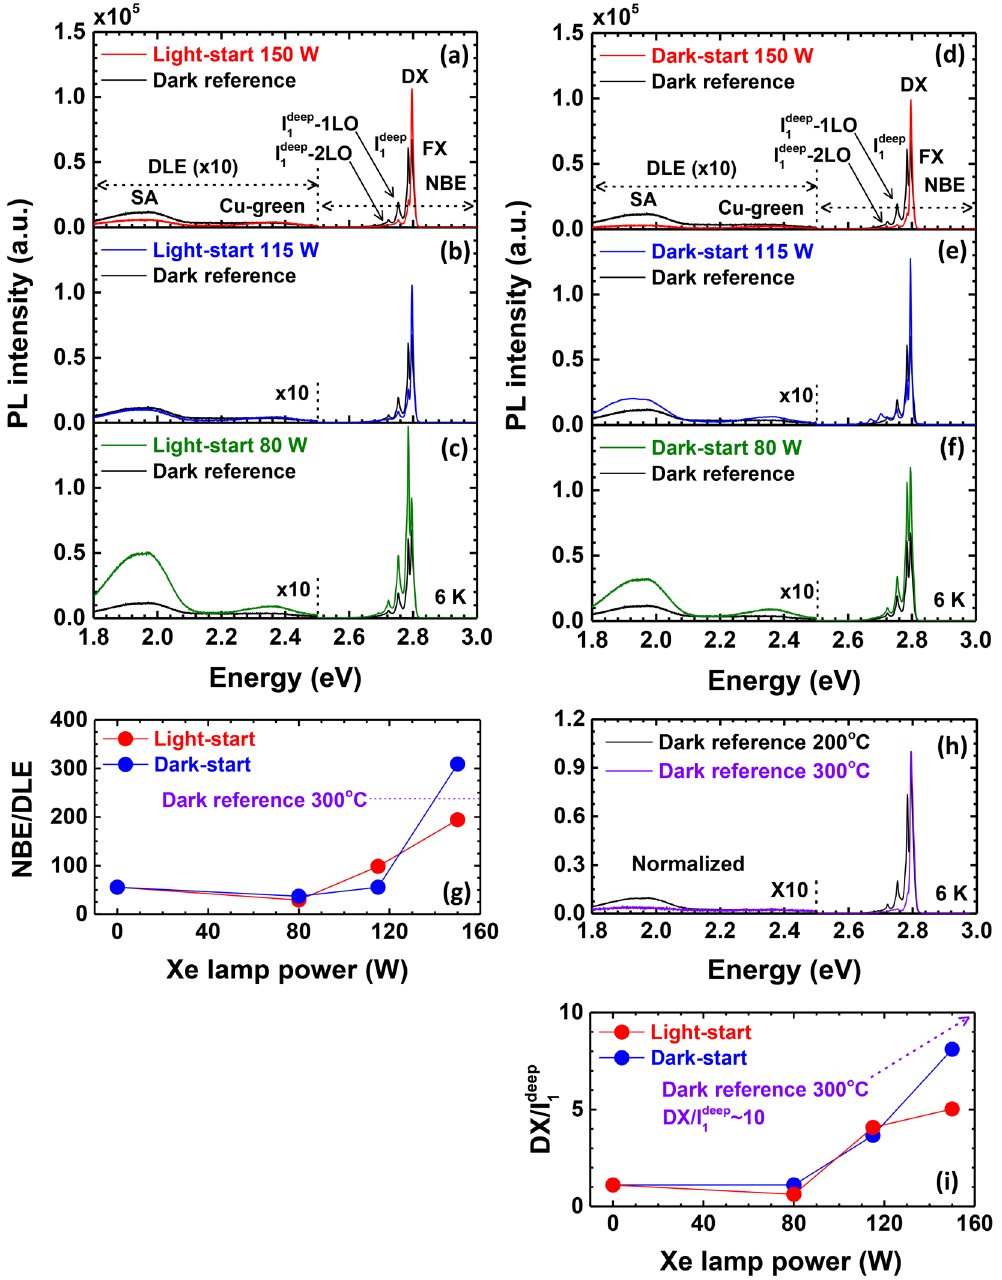
Figure 5. ( a – f ) PL emission from the ZnSe epilayers grown under light-start and dark-start conditions, respectively. The PL spectra consist of emission from NBE and DLE regions. The DLE region is divided into SA and Cu-green emission. ( g ) The NBE/DLE peak intensity ratio of light-start samples as a function of Xe lamp power. ( h ) The normalized PL spectrum of dark reference samples grown at 200 °C and 300 °C. With increasing Xe lamp power, the PL spectrum of the 200 °C-grown ZnSe epilayer approaches that of the 300 °C - grown ZnSe epilayer, with suppressed I 1deep and DLE emission. ( i ) DX/I 1deep ratio of light-start and dark-start samples. DX/ I 1deep increase with lamp power approaching that of 300 °C-grown